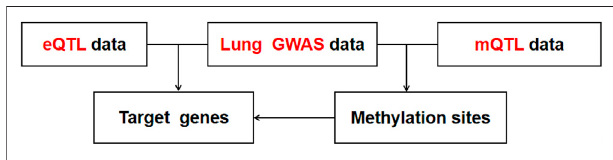
FIGURE 5 | The process of GWAS, eQTL, and mQTL conjoint analysis.